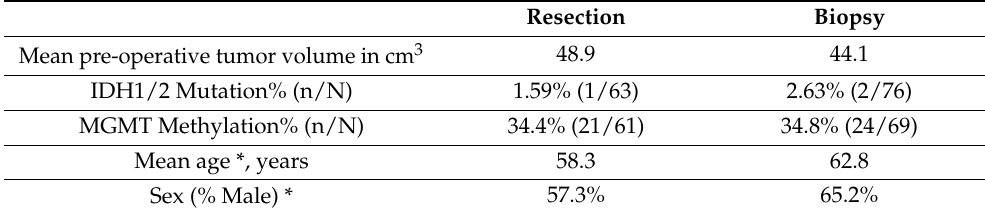
Table 2. Comparison of pre-operative tumor volume, genetic profile, age, and sex between the resection and biopsy groups.